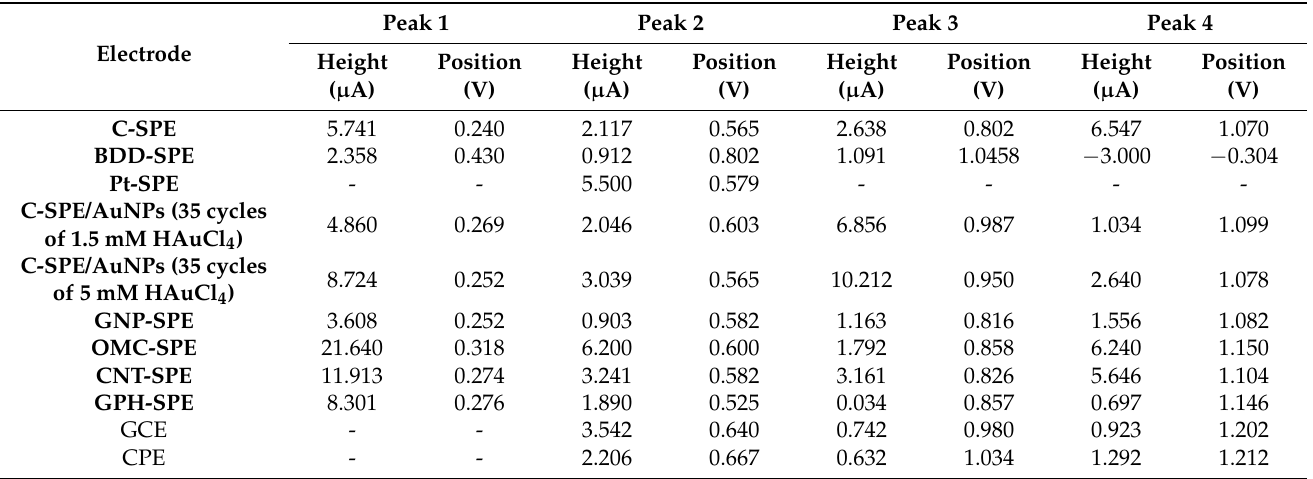
Table 1. The height/position of the peaks obtained by CV of a 50 µ M PQS in 0.5 M H 2 SO 4 on different electrode materials (1st scan).